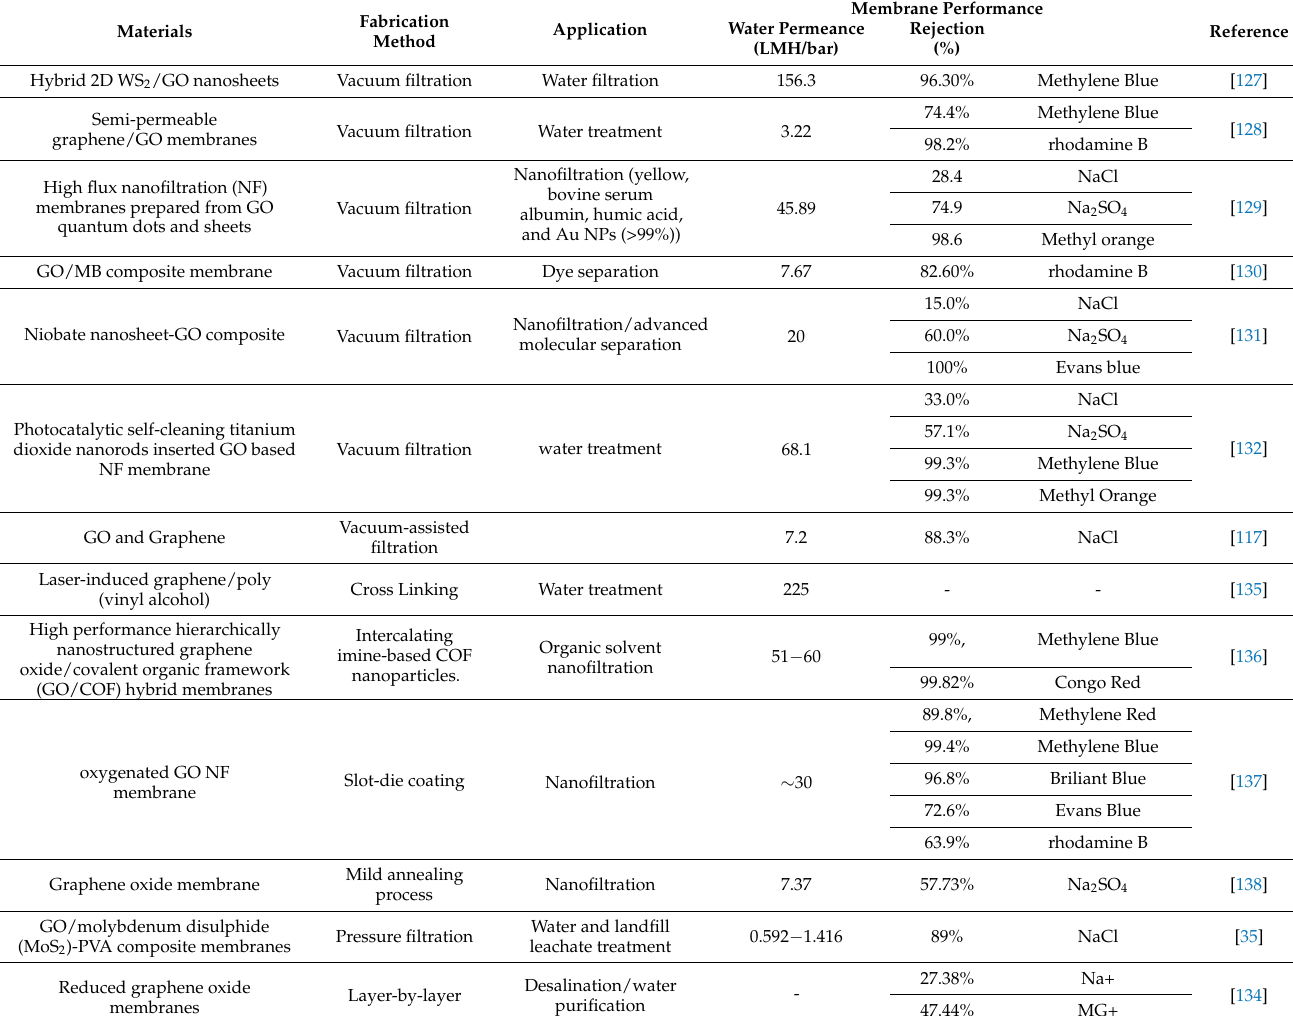
Table 2. Performance of graphene separation and decontamination